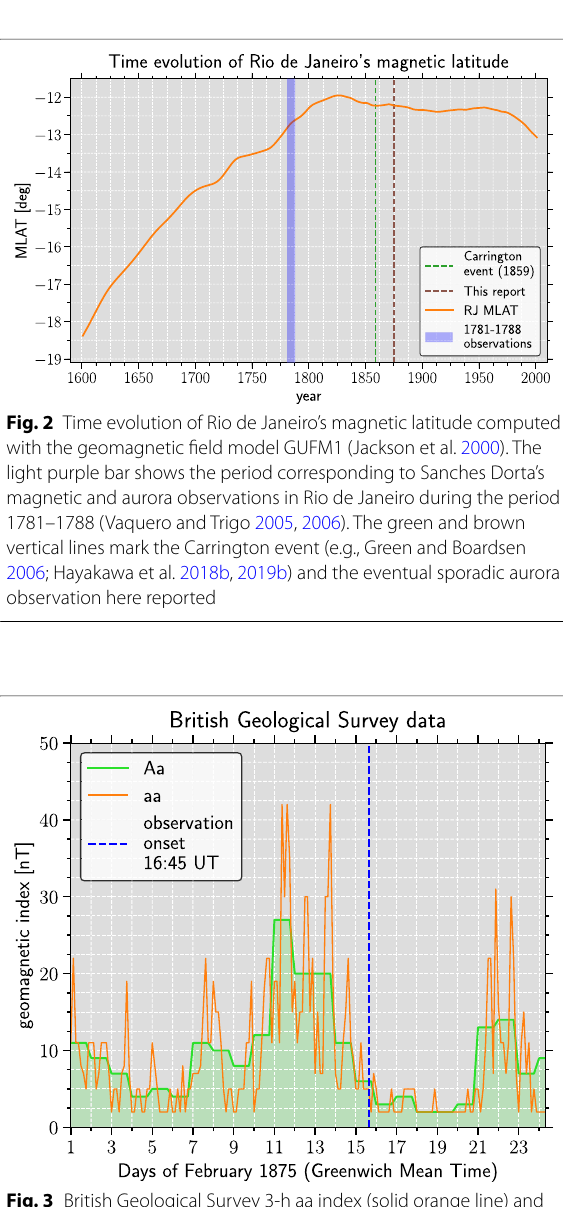
1816 when it started to decrease again. The highlighted 1781–1788 interval between aurorae observed from Rio de Janeiro. The dashed green vertical line marks the Car- rington event occurrence (1859), while the dashed brown vertical line indicates the event reported in this letter (1875).